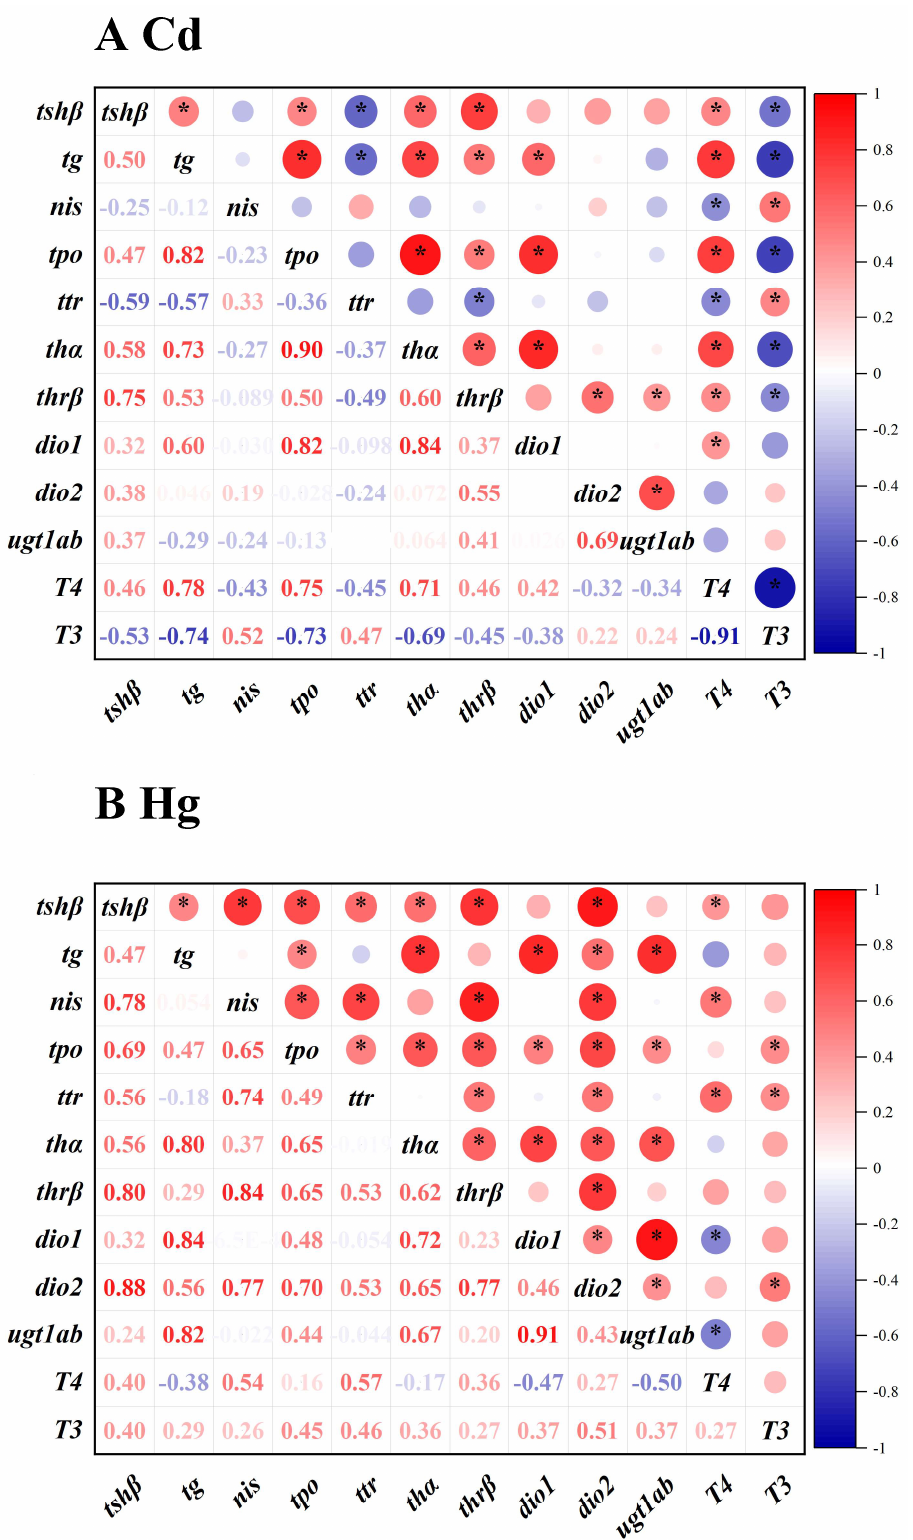
Figure 4. Heatmap of correlation coefficients between the thyroid hormones (THs, including T4 and T3) contents and the gene expression levels in the zebrafish embryos (2 hpf) that were treated with Cd 2+ (0, 10, 100, and 1000 µ g/L) ( A ) and Hg 2+ (0, 0.1, 1, and 10 µ g/L) ( B ) for 120 h. The scale indicates the level of positive (red) or negative (blue) correlation, and * indicates significance (* p <